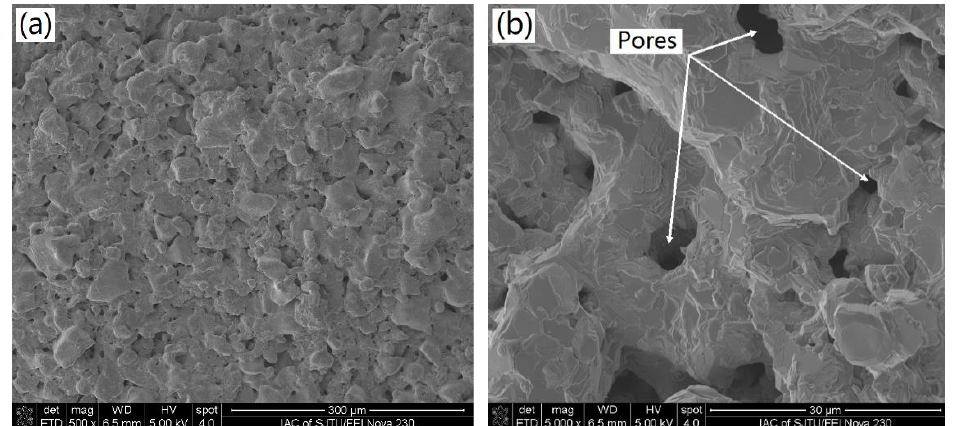
Figure 8. SEM micrographs of sintered TiAl alloys. ( a ) 500 × and ( b ) 5000 ×.